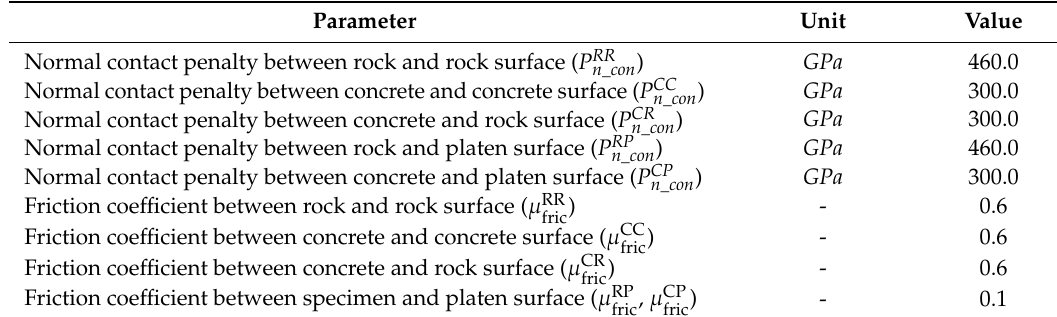
Table 3. Calibrated FDEM input parameters for simulating contact behavior in the simulation of direct shear